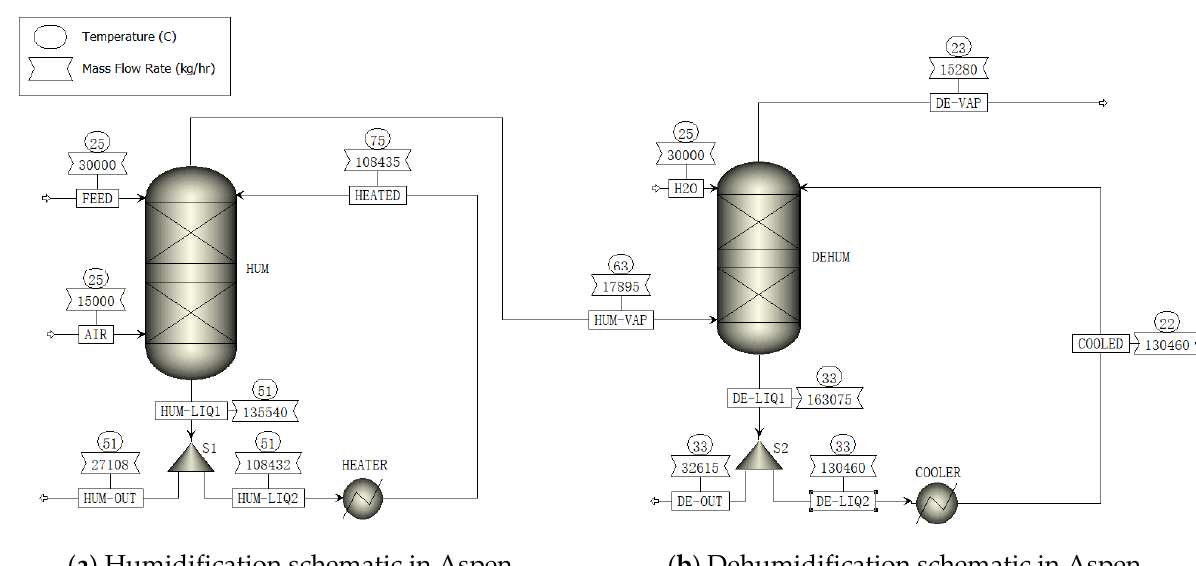
Figure 7. Overall HDH schematic with simulation result.